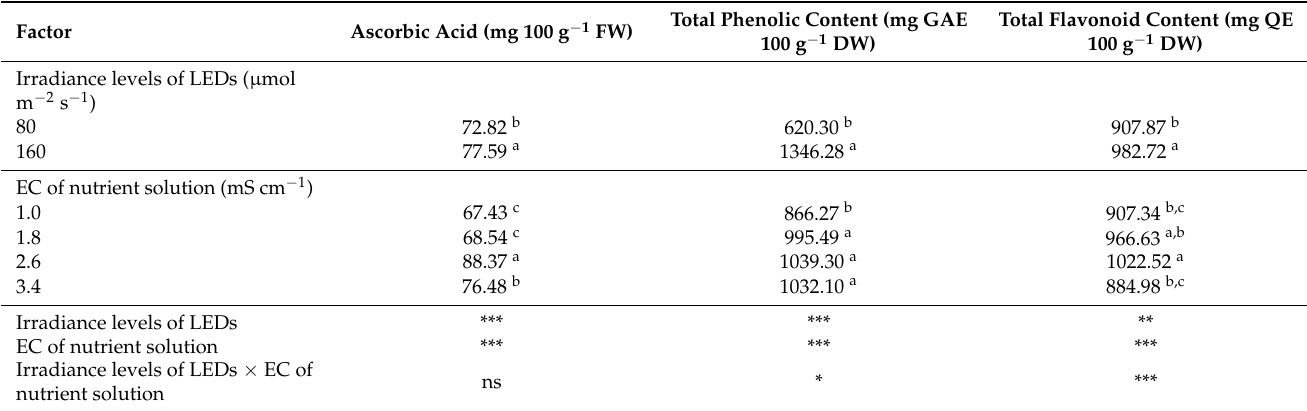
Table 5. Effects of LED irradiance levels and nutrient solution EC on ascorbic acid, total phenolic, and total flavonoid contents in lemon basil.